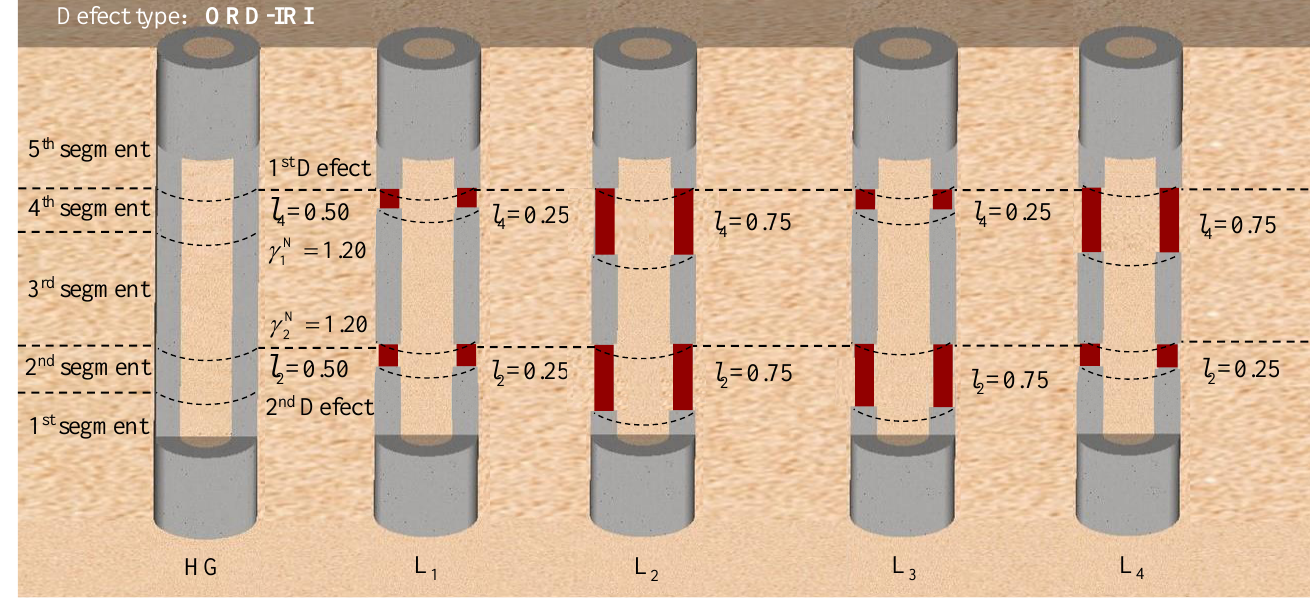
Figure 9. Diagram of necking defect with different lengths.